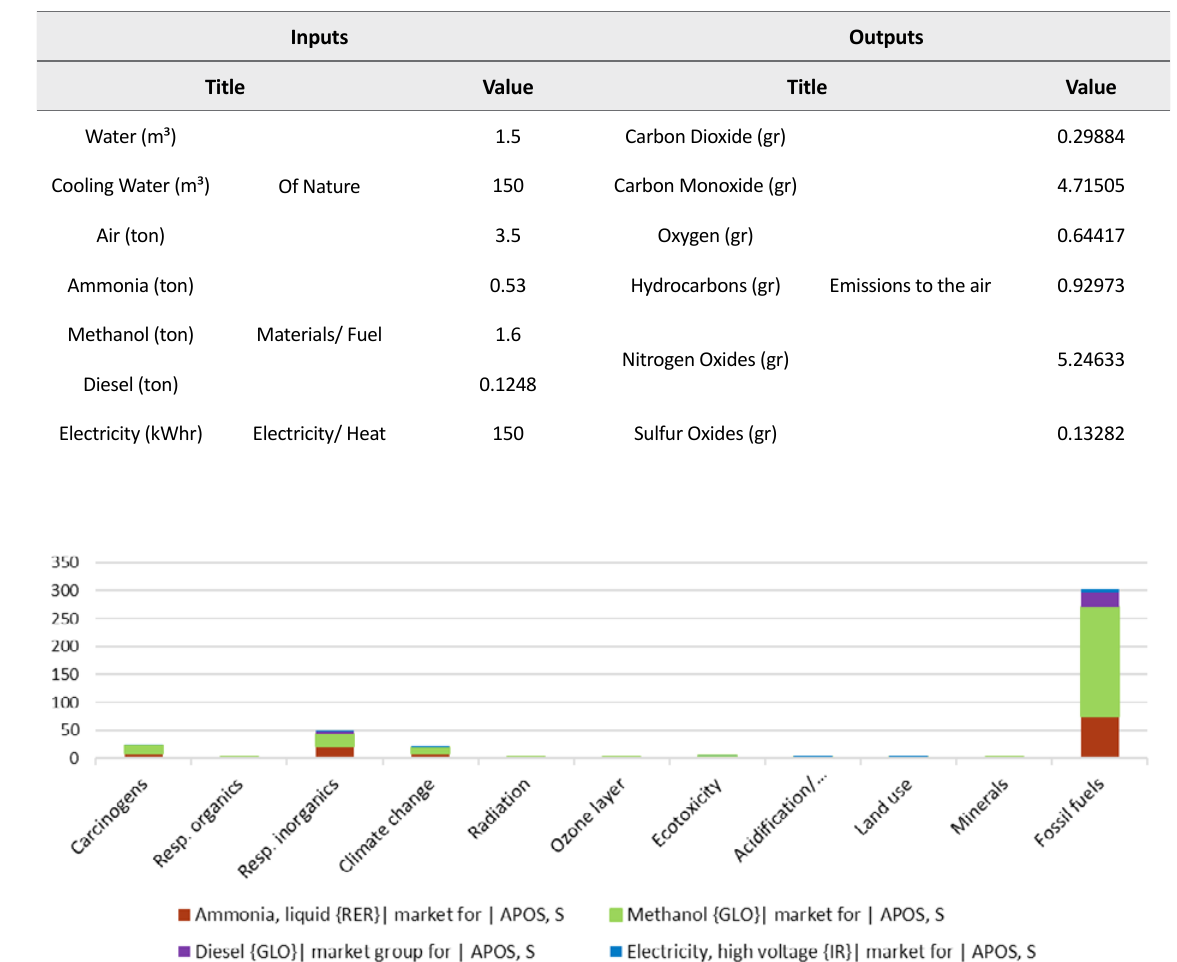
Table 1. Production process life cycle log of 800 kg hexamine and 200 kg formalin [28]